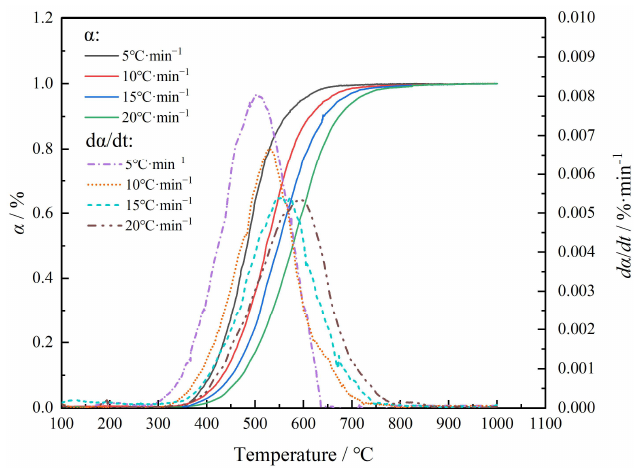
Figure 9. α and dα / dt versus time (t) for different heating rates.